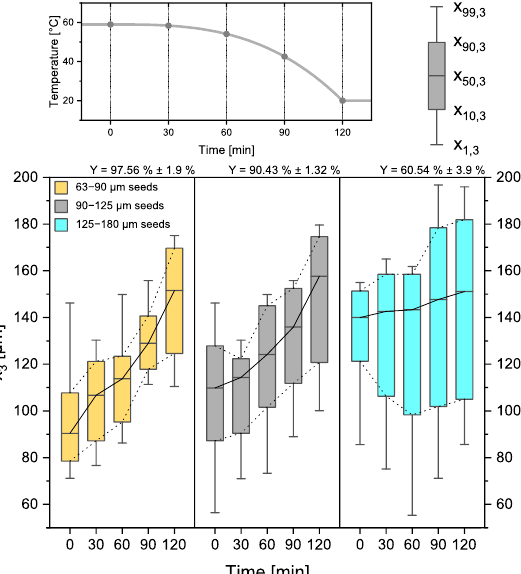
Figure 11. CSDs for three different seed crystal sizes (63-90µm, 90-125µm, 125-180µm). The temper- ature profile and sampling times can be seen in the top panel. Respecting yields are given above the Boxplots. Progressive profile, process time t process = 120min, seed crystal amount ω SC = 0.025g · g − 1